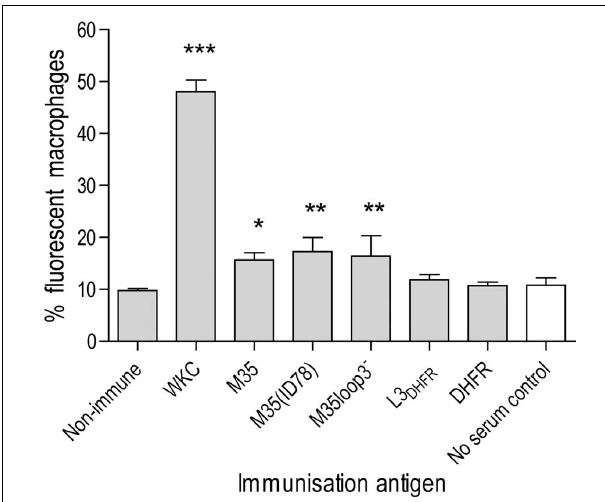
FIGURE 4 | Percentage of macrophages with enhanced fluorescence due to phagocytosis of M. catarrhalis 2:03KAL opsonized by antibodies raised against the M35-derived antigens .Values are the mean of triplicate assays. Error bars show SD. Asterisks indicate statistical significance compared to the non-immunized control group: * p < 0.05, ** p < 0.01, *** p < 0.001.The assay control is unshaded.